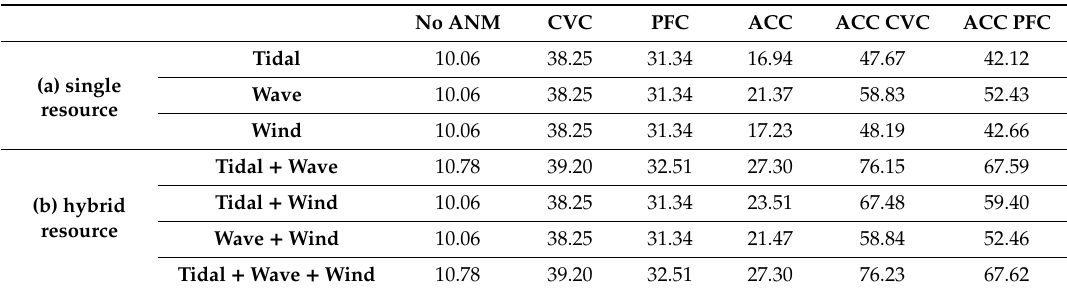
Table 5. Connected generation capacity (MW) for a range of network control configurations. Rows indicate the generation types connected to the network. Columns indicate the network management scheme(s).